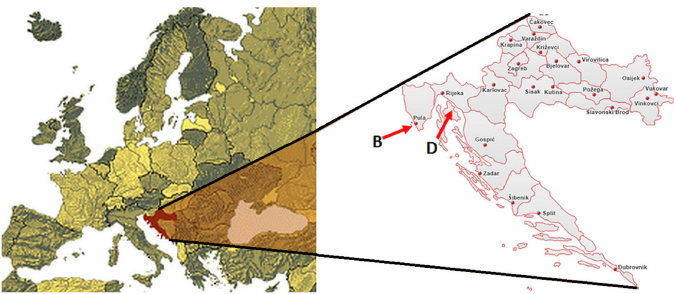
Figure 1. Geographic area of cultivation of Drobnica (D) and Buza (B)